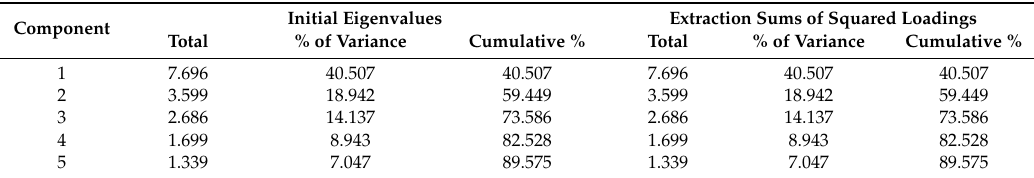
Table 4. Total variance explanation of